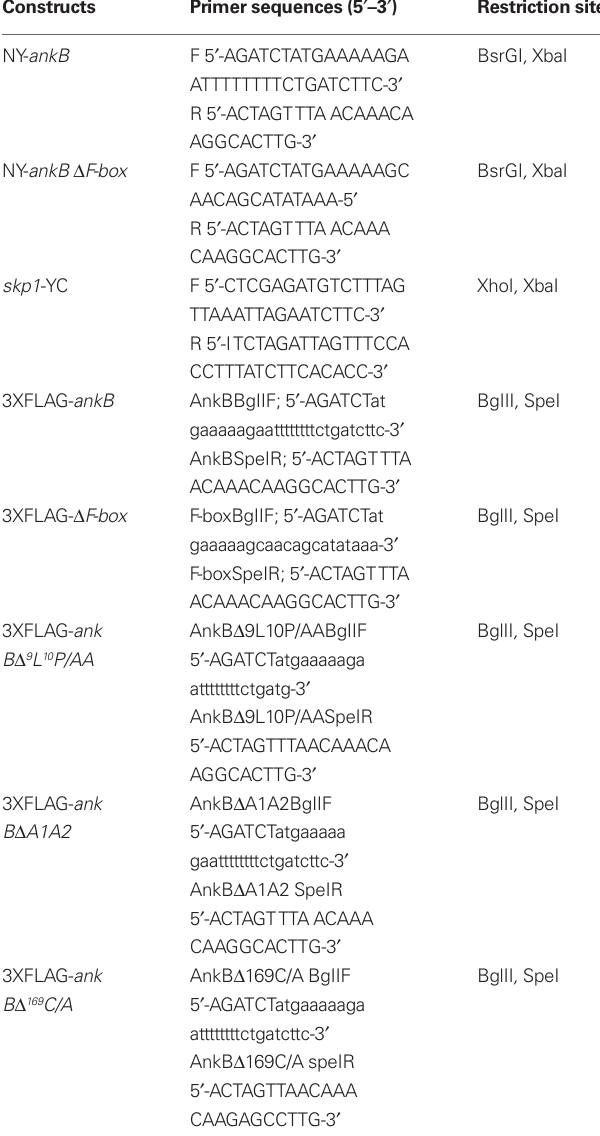
Table 1 | List of primers used to generate corresponded